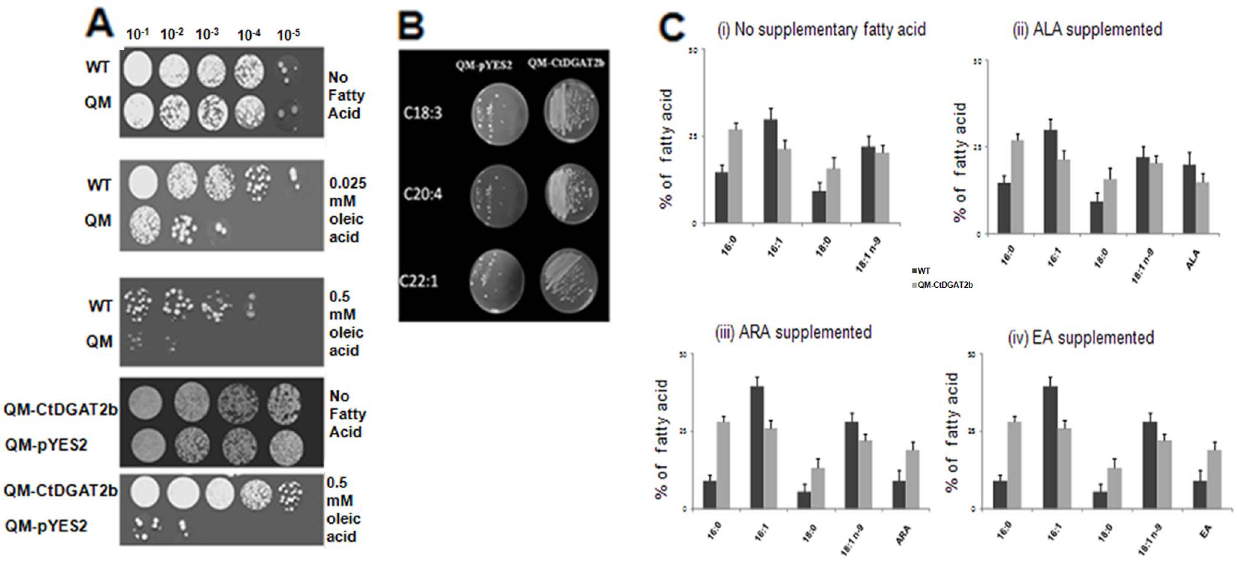
Figure 5. Enzymatic activity of CtDGAT2b in S.cerevisiae QM strain rescues the yeast cells from the cytotoxic effect due to free fatty acid in growth medium. (A) Growth rescue of transformed QM cells in oleic acid containing media. Yeast nitrogen base media was used for the growth of wild-type (WT) and non-transformed QM cells with dextrose and uracil, whereas raffinose and galactose with no uracil was used for the QM transformant (QM-pYES2 or QM-CtDGAT2b) to induce the expression of transgene. Two microliters of yeast cells (O.D. 1), after serial dilutions (10 2 1 , 10 2 2 , 10 2 3 , 10 2 4 and 10 2 5 ) were spotted on solid media without or with 0.025 mM and 0.5 M oleic acid. (B) Growth phenotype of QM cells harboring non-recombinant plasmid pYES2 (QM-pYES2) and recombinant plasmid with the CtDGAT2b gene (QM-CtDGAT2b) on solid media supplemented with three different fatty acids- a -linoleic acid (C18:3), arachidonic acid (C20:4), erucic acid (C22:1) after 4 days at 30 u C. (C) Fatty acid composition of TAGs isolated from the wild-type yeast (WT) and transformed QM cells (QM-CtDGAT2b) grown in liquid media (i) without any free fatty acid, and supplemented with (ii) a -linolenic acid (ALA), (iii) arachidonic acid (ARA) and (iv) erucic acid (EA).